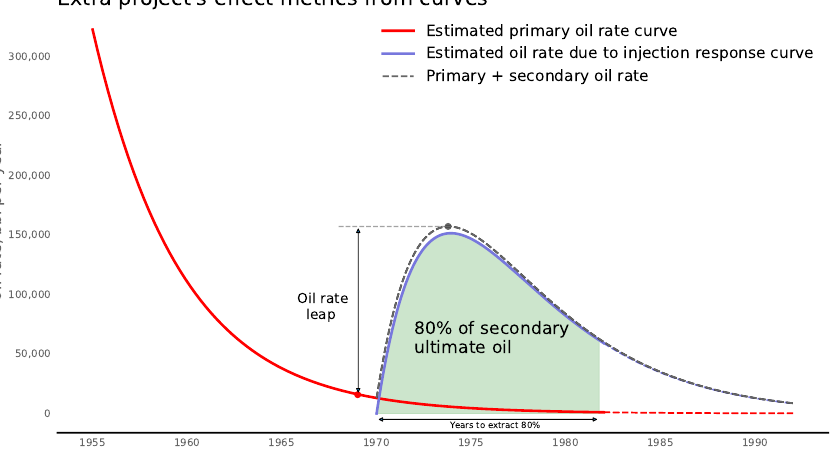
Figure 4. The plot demonstrates how extra metrics can be calculated using production curves. Oil rate leap is the difference between the oil rate before a project has started and the peak of total oil production after project initiation. Years to extract 80% of oil attributed to secondary recovery can be estimated calculating area under the secondary production